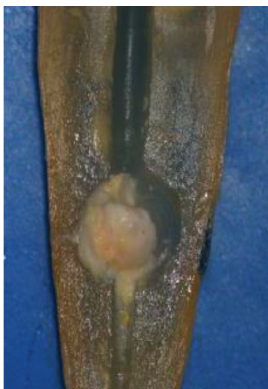
Figure 3: Score 2. More than half of the cavity is filled with CH remnants.